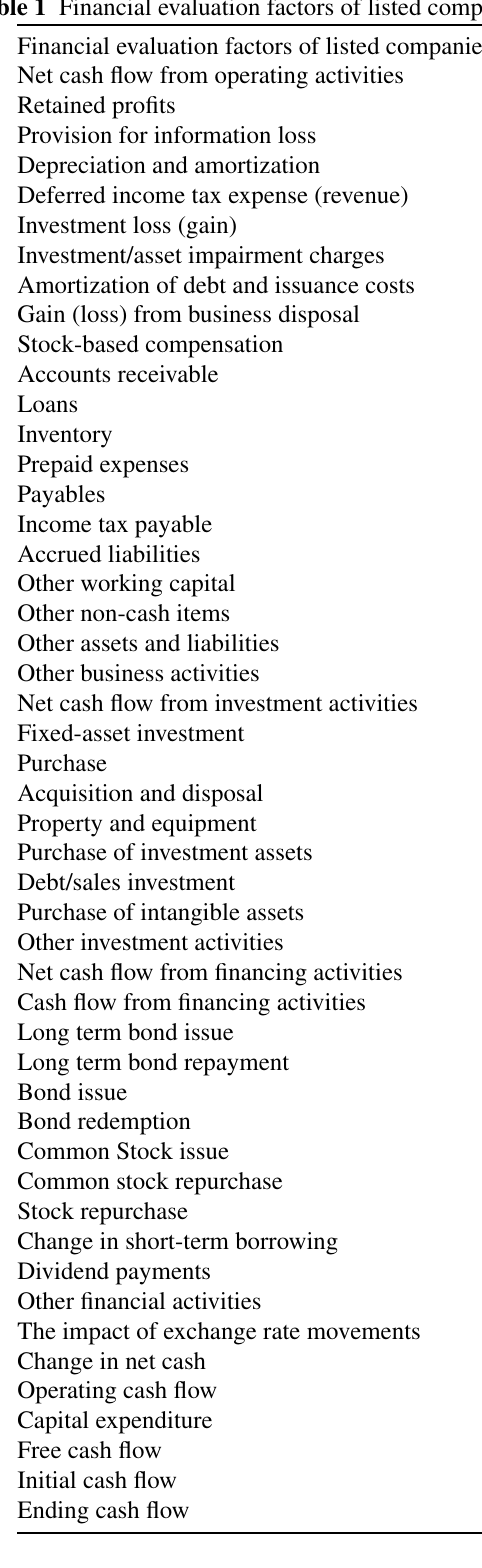
Table 1 Financial evaluation factors of listed